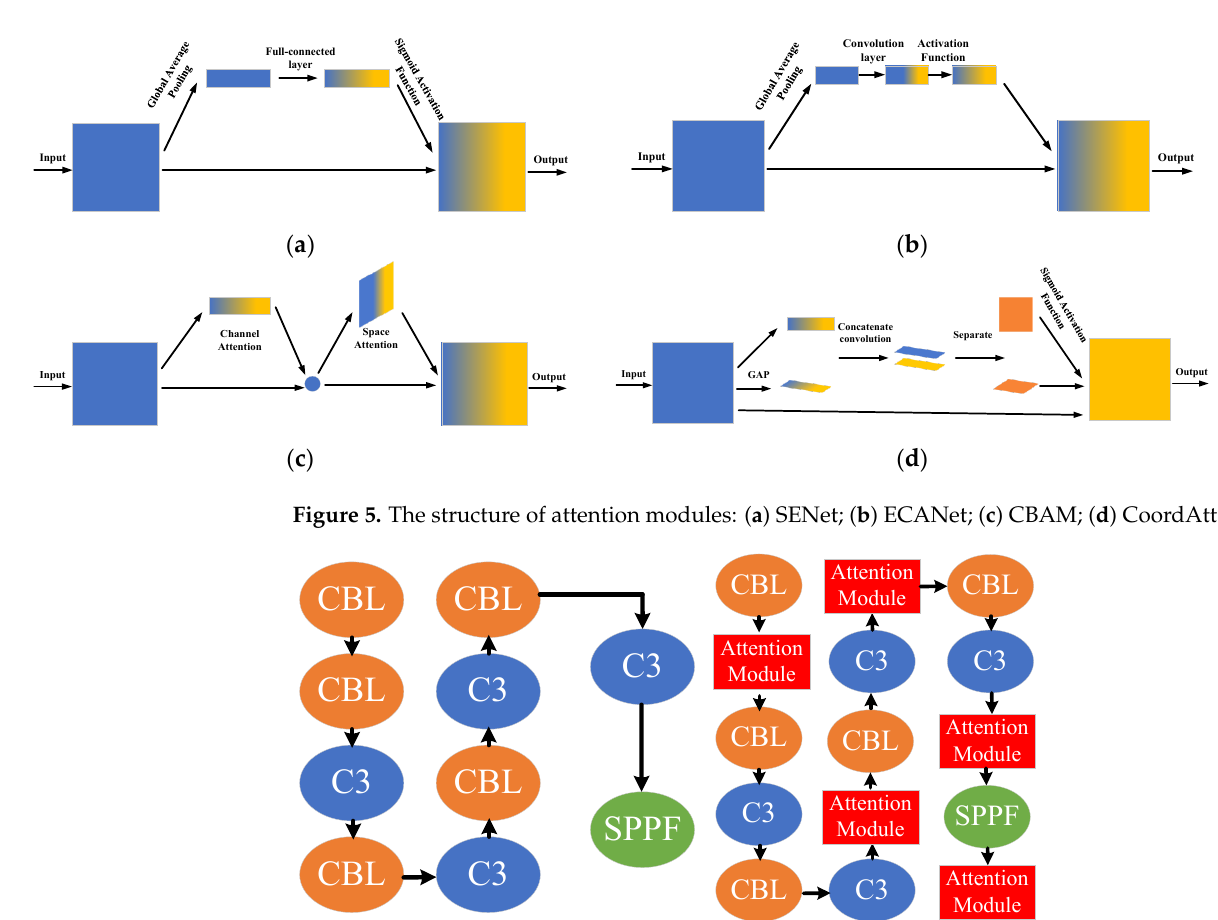
backbone with attention modules.